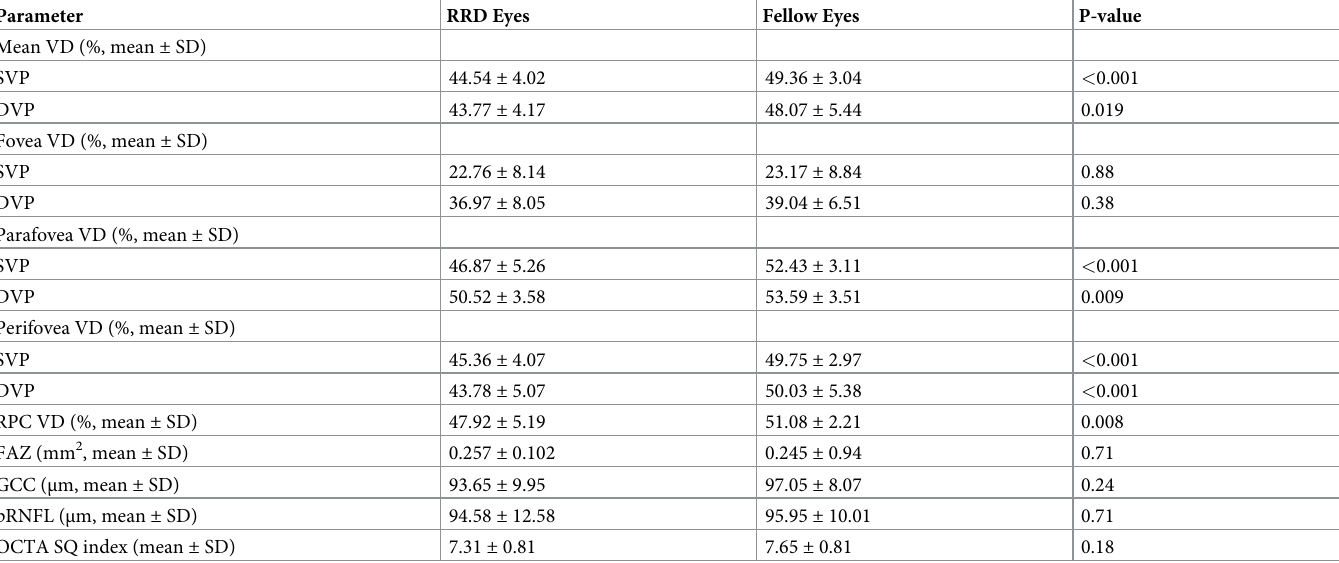
Statistical significance tested by t-Student’s test or the Wilcoxon’s tests. P-values adjusted for SQ (in SVP, DVP and RPC), based on Linear Mixed Effects Model. P-value < 0.05 was considered to be statistically